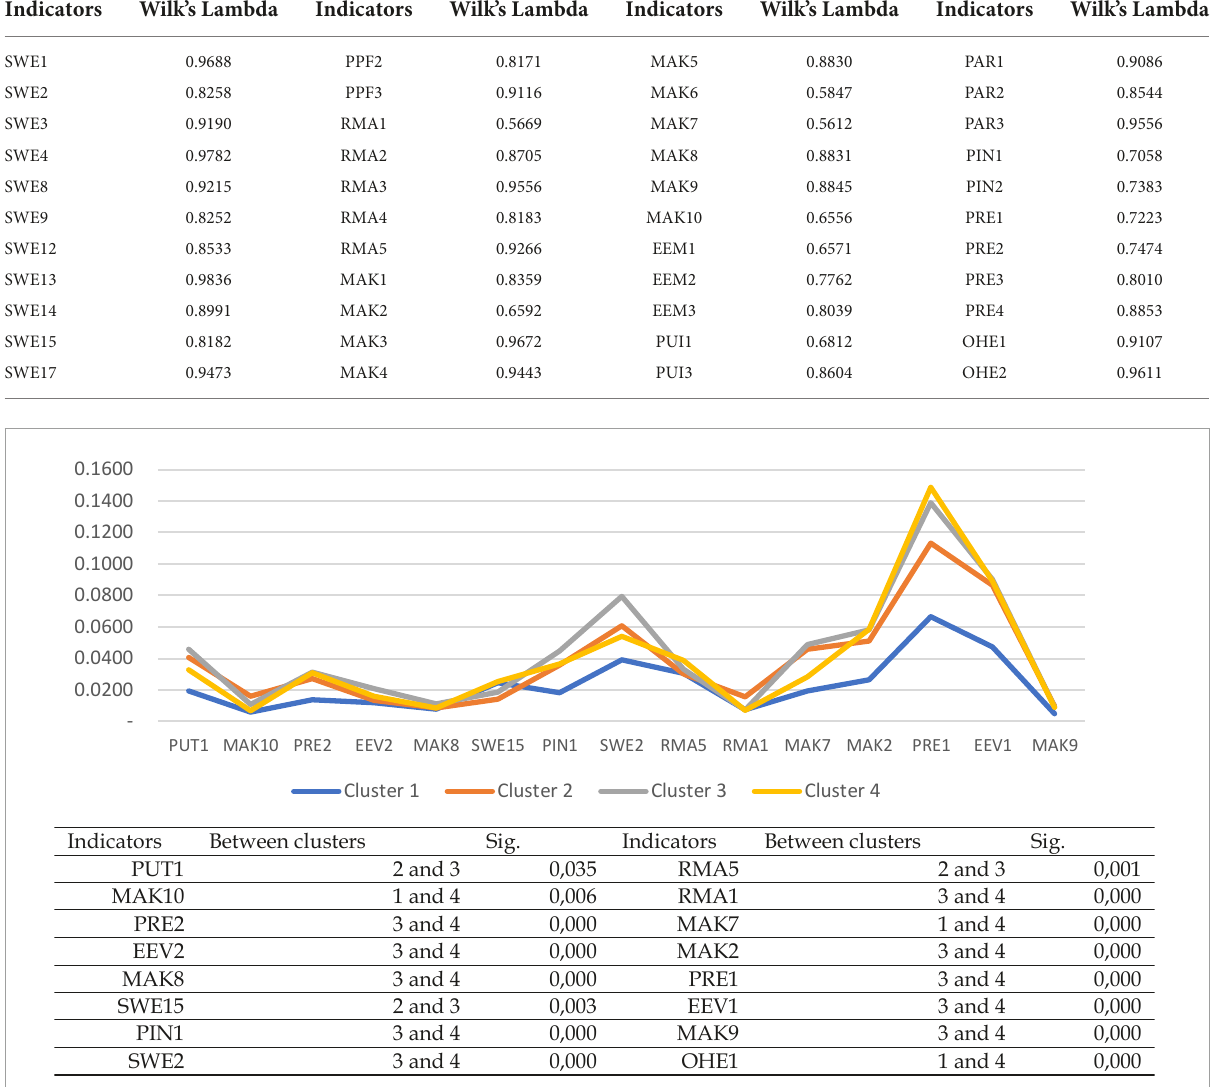
FIGURE7 The result of checking the best indicators to identify four cluster segments in each function by entering or removing a